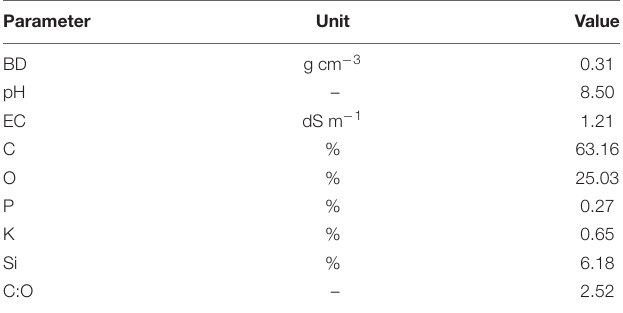
TABLE 2 | Mean ( n = 3) of the physiochemical characteristics such as bulk density (BD), pH, cation exchange capacity (CEC), silicon (Si), aluminum (Al),